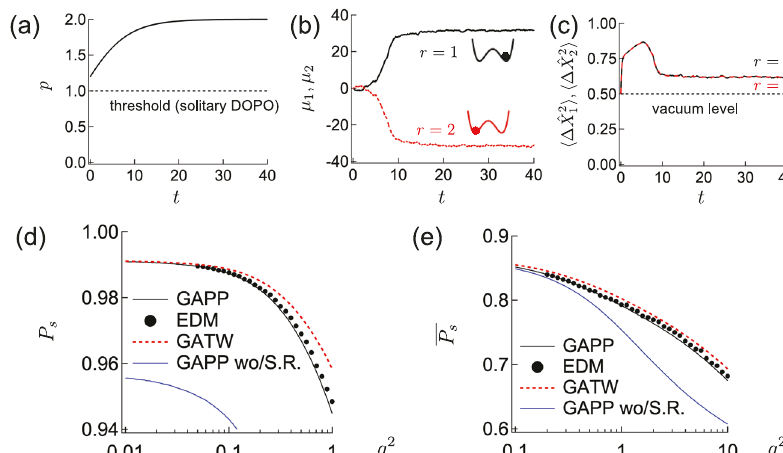
i ; h Δ ^ X 2 i ) of 1 2